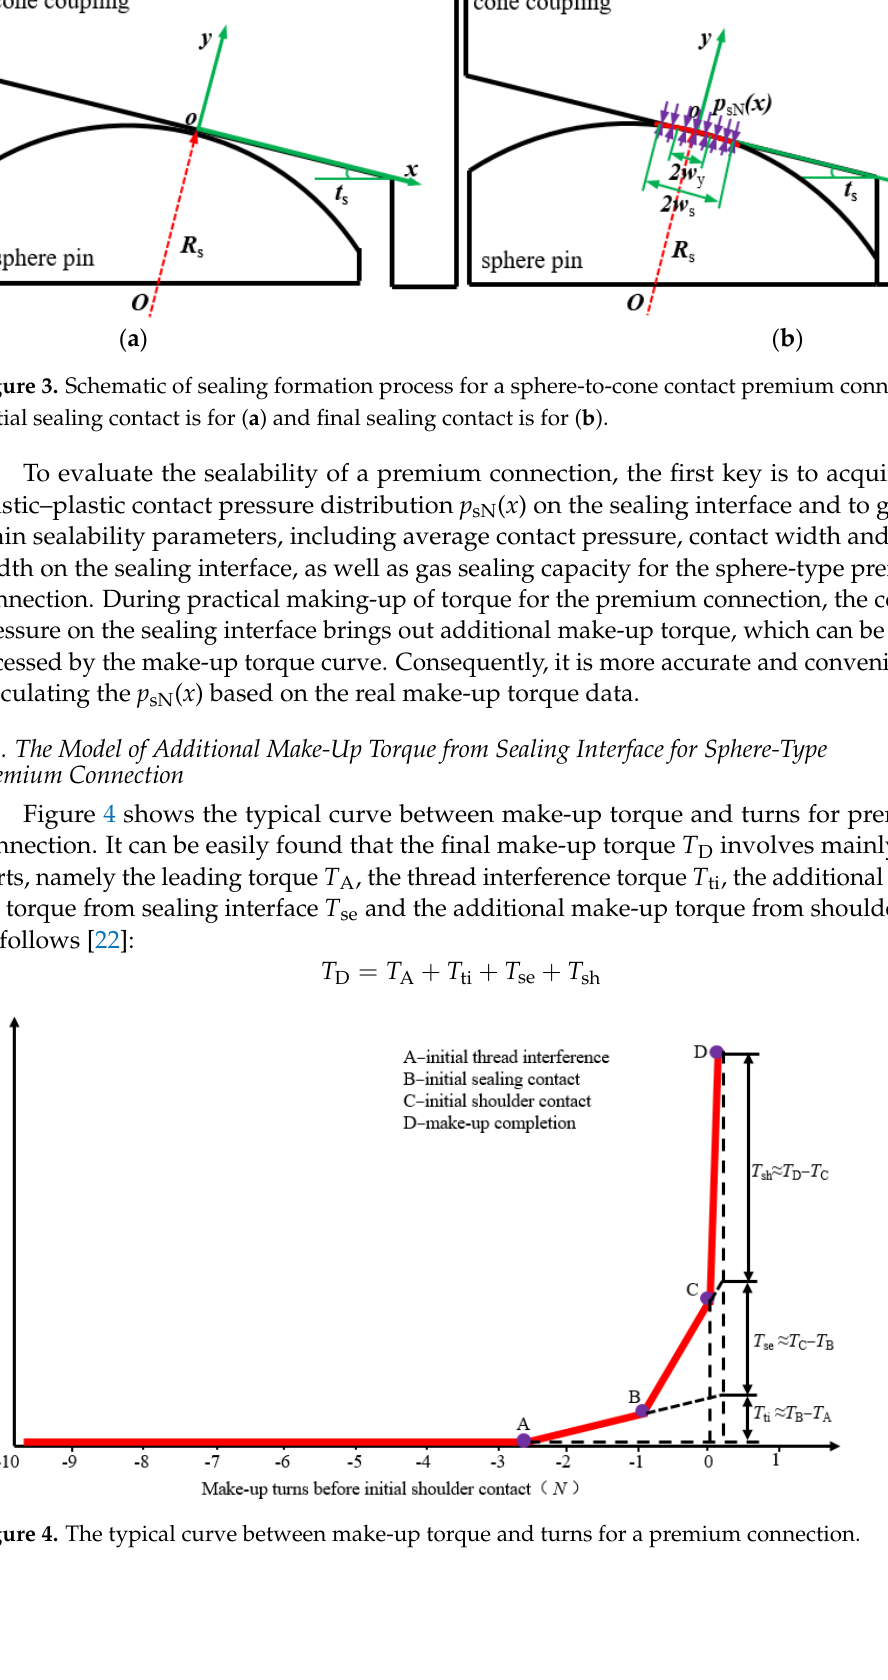
(5) In Equation (5), the equivalent moment arm for thread friction torque is as follows: